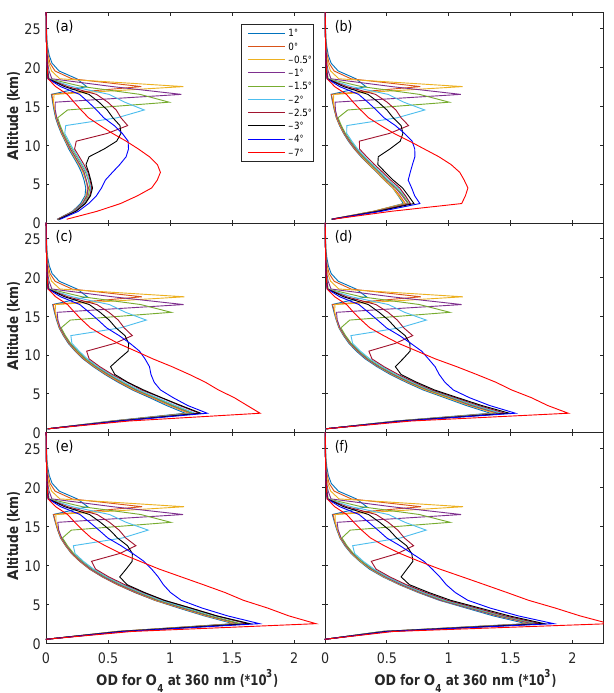
Figure 7. Altitude-dependent contribution to the simulated optical densities of the O 2 –O 2 collisional complex (O 4 ) at 360nm for limb measurements at 18km and different observation angles, as indi- cated in the legend of panel (a) . In the simulations, a deck of marine stratocumulus clouds (mSc) located between 1 and 2km of different cloud optical depth τ mSc is assumed, since according to the cloud physics lidar measurements (CPL), mSc clouds were frequently oc- curring during the NASA ATTREX flights over the eastern Pacific. Panel (a) is for clear skies, panel (b) for τ MSc = 1, panel (c) for τ mSc = 5, panel (d) for τ mSc = 10, panel (e) for τ mSc = 20, and panel (f) for τ MSc = 50. The integral under the curves corresponds to the optical density a limb observer would measure for the given